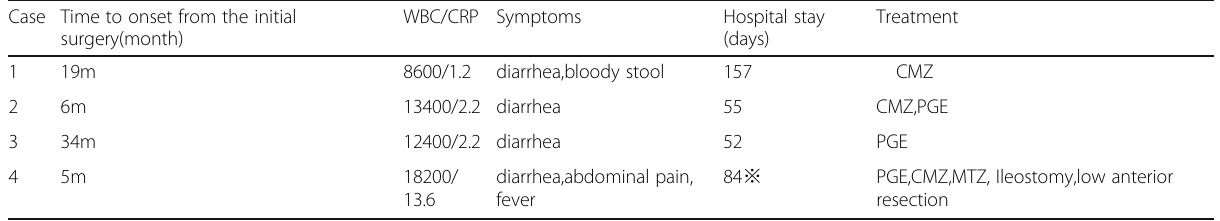
Table 2 Details of the treatment received by the 4 cases Case Time to onset from the initial surgery(month)